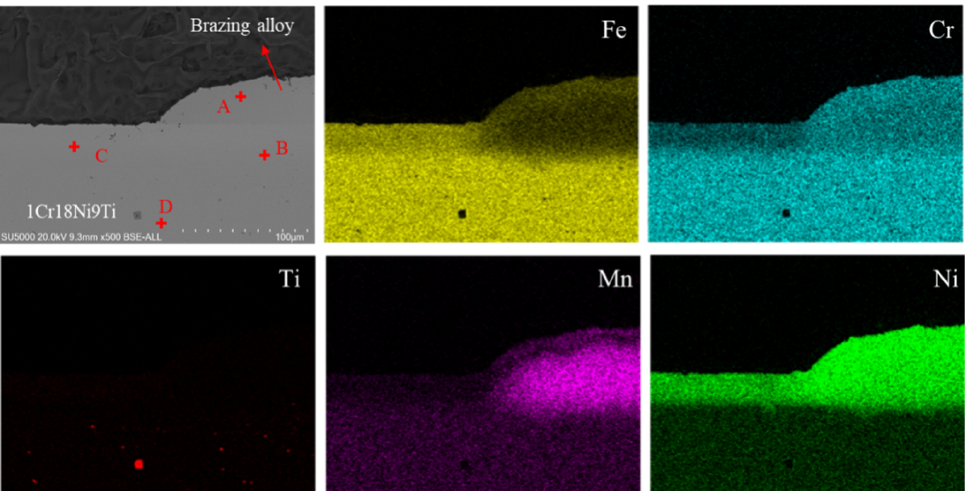
Figure 9. The SEM image and the corresponding element map distribution of brazing alloy on substrates of acid treatment + 10 µ m Ni at 1170 ◦ C/25 min. Table 5. The EDS results in Figure 9. Element